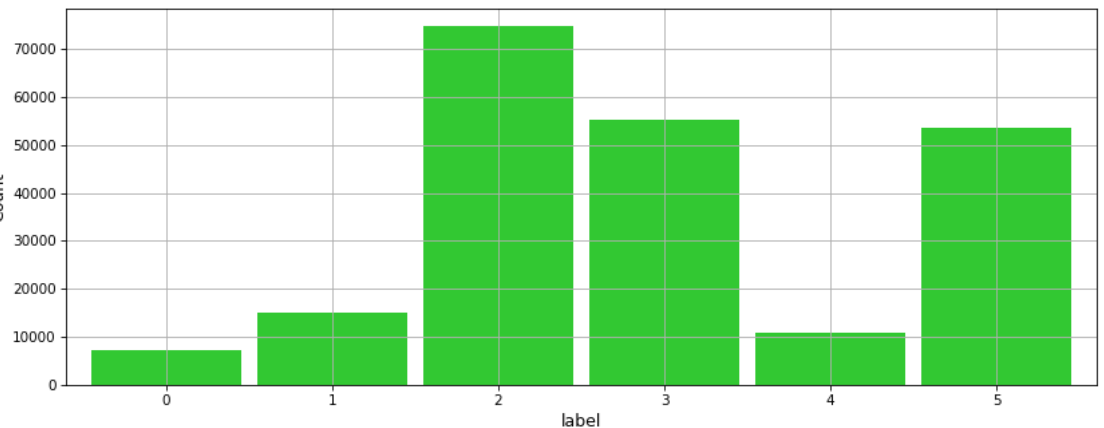
Figure 9. High class skewness for the Vehicle Activity Recognition dataset.